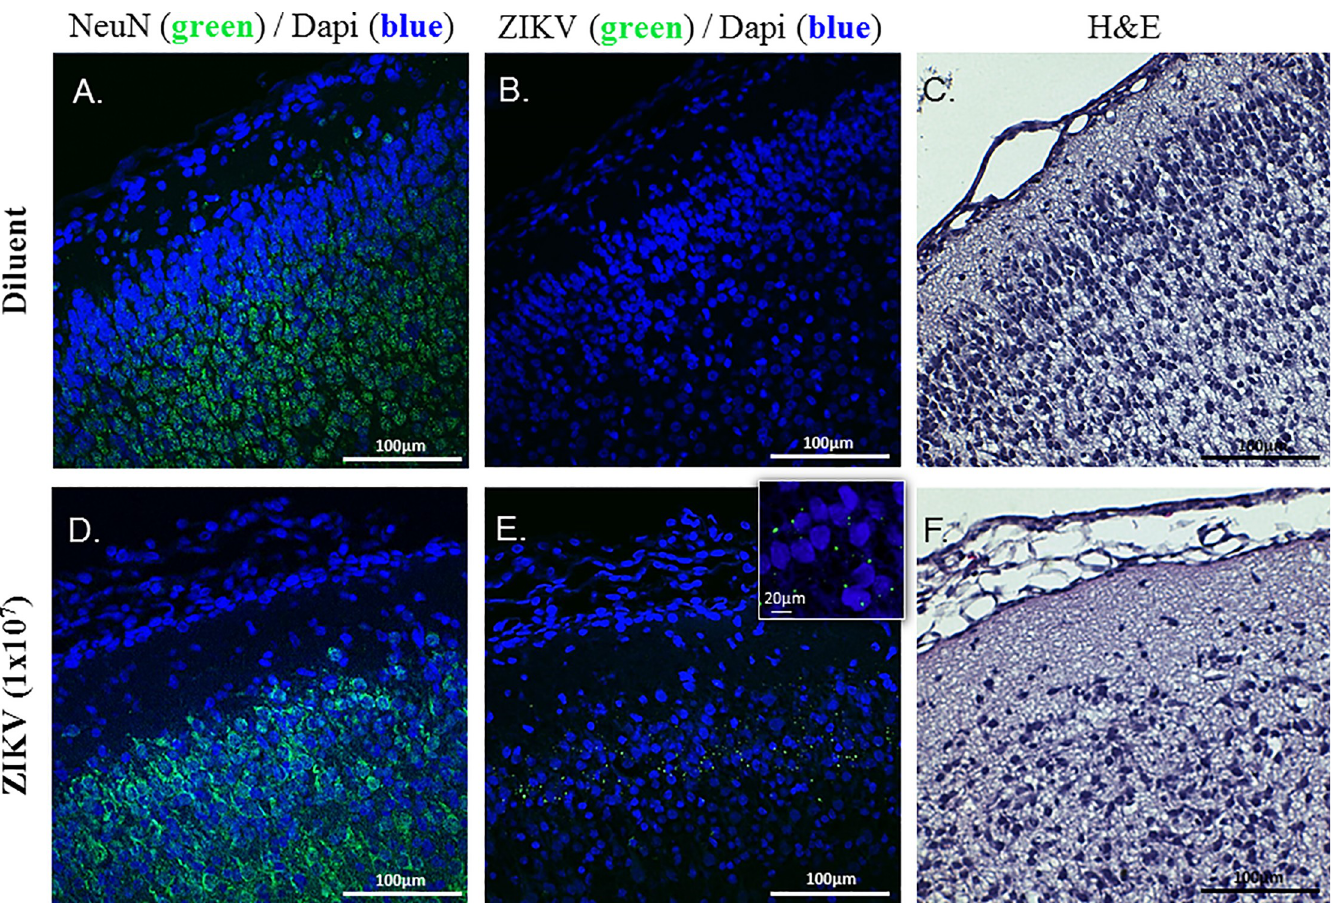
Fig 3. Histopathologic analysis of the pup brains. Hematoxylin and Eosin (H&E) staining ( C, F ) in conjunctions with anti-NeuN staining (NeuN: Green; DAPI: Blue; A, D) identified differences in neuronal arrangement and within the cerebral cortex of pups from ZIKV-treated dams, a finding that was indicative of cerebrocortical dysplasia. Anti-ZIKV staining identified viral presence in the ZIKV cortex with no positive staining found in the control animals (ZIKV: Green; DAPI: Blue; B, E ). n = 4 animals per group. (20X magnification, scale bar = 100 μ m; higher magnification image on panel E was taken at 40X, scale bar = 20 μ m).